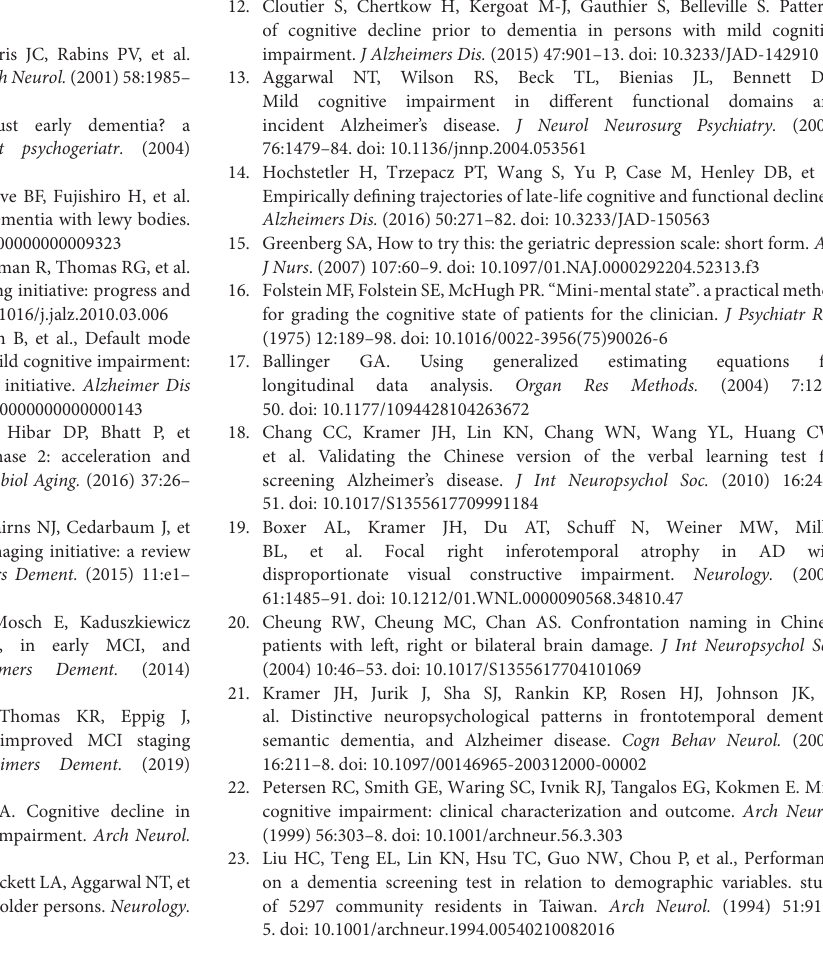
test; CFT, complex figure test; BNT, Boston naming test; TMT, trail making test; VF, verbal fluency. Supplementary Table 1 | Generalized Estimating Equation (GEE) analysis of annual change rate in each neuropsychological test. NC, normal cognition; EMCI, early mild cognitive impairment; LMCI, late mild cognitive impairment; GDS, Geriatric Depression Scale; MMSE, mini-mental status examination; STM, short-term memory; WMS-LM, Wechsler memory scale-logical memory; CVVLT, Chinese version of the verbal learning test; CFT, complex figure test; BNT, Boston naming test; TMT, trail making test. Supplementary Table 2 | Generalized Estimating Equation (GEE) analysis of annual change rate differences between EMCI and LMCI in each neuropsychological test. NC, normal cognition; EMCI, early mild cognitive impairment; LMCI, late mild cognitive impairment; GDS, Geriatric Depression Scale; MMSE, mini-mental status examination; STM, short-term memory; WMS-LM, Wechsler memory scale-logical memory; CVVLT, Chinese version of the verbal learning test; CFT, complex figure test; BNT, Boston naming test; TMT, trail making